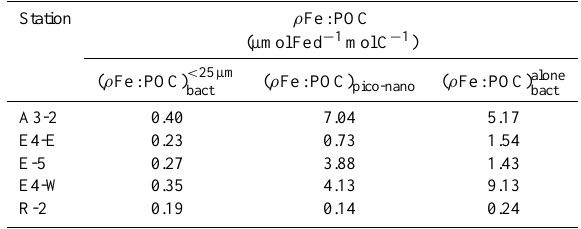
Table 6. Carbon normalized Fe uptake rates for bacteria and pico- nanoplankton. Columns ( ρ Fe:POC) < 25µm and ( ρ Fe:POC) alone bact bact are for bacteria incubated with pico-nanoplankton only and bacte- ria incubated alone, respectively. The column ( ρ Fe:POC) pico-nano stands for pico-nanoplankton. We note that this Fe uptake rate for pico-nanoplankton was measured during incubations with bacteria. Because pico-nanoplankton largely outcompeted bacteria, this rate, ( ρ Fe:POC) pico-nano , is a good approximation of the Fe uptake rate for pico-nanoplankton incubated alone. Values are from incubations performed at 1% of the PAR